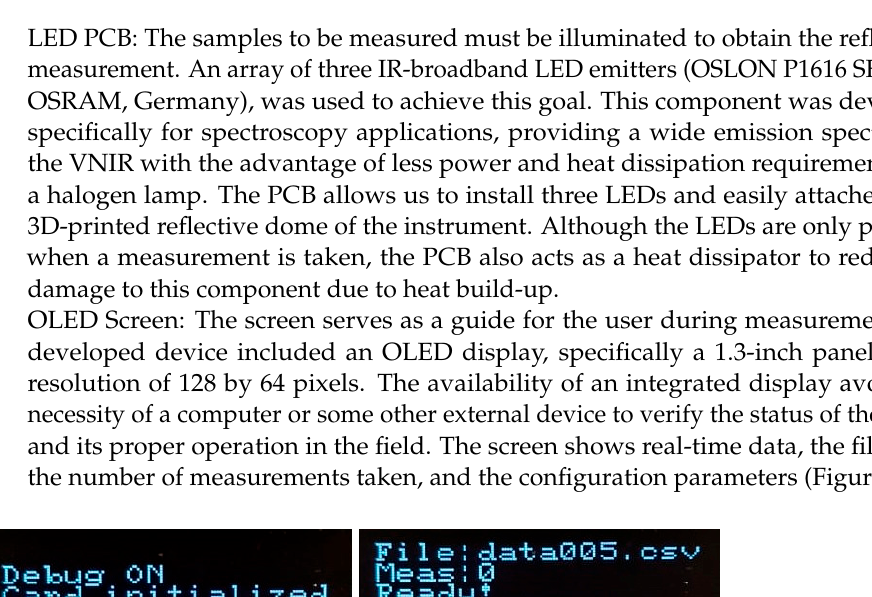
Figure 1. Schema of the different components of the low-cost multispectral device, including the interconnections between them.